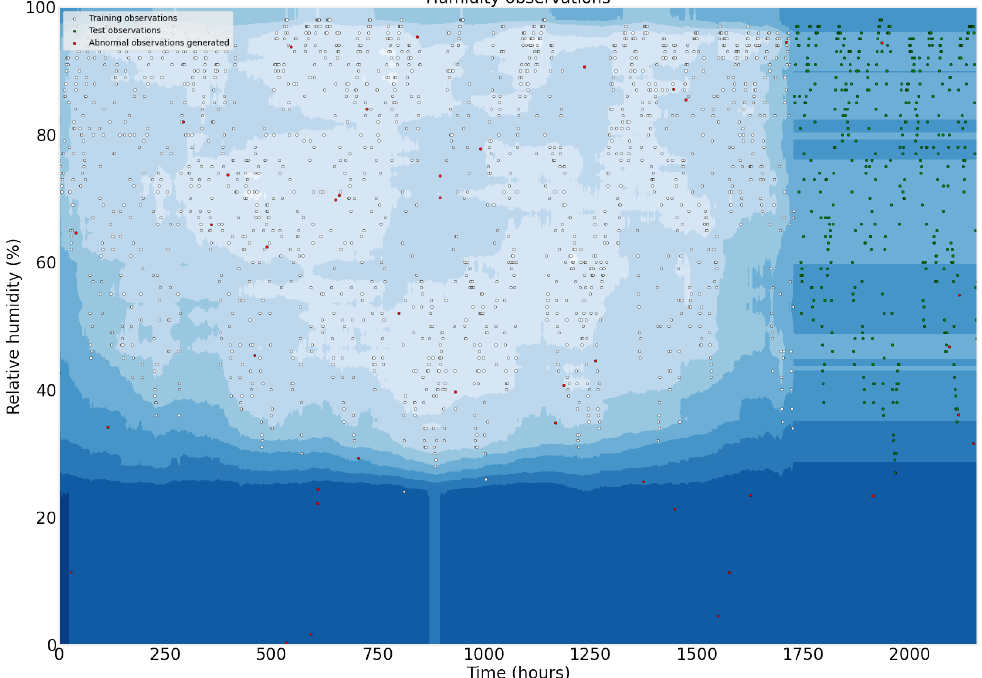
Figure 30. Humidity observations used to train and test the Isolation Forest